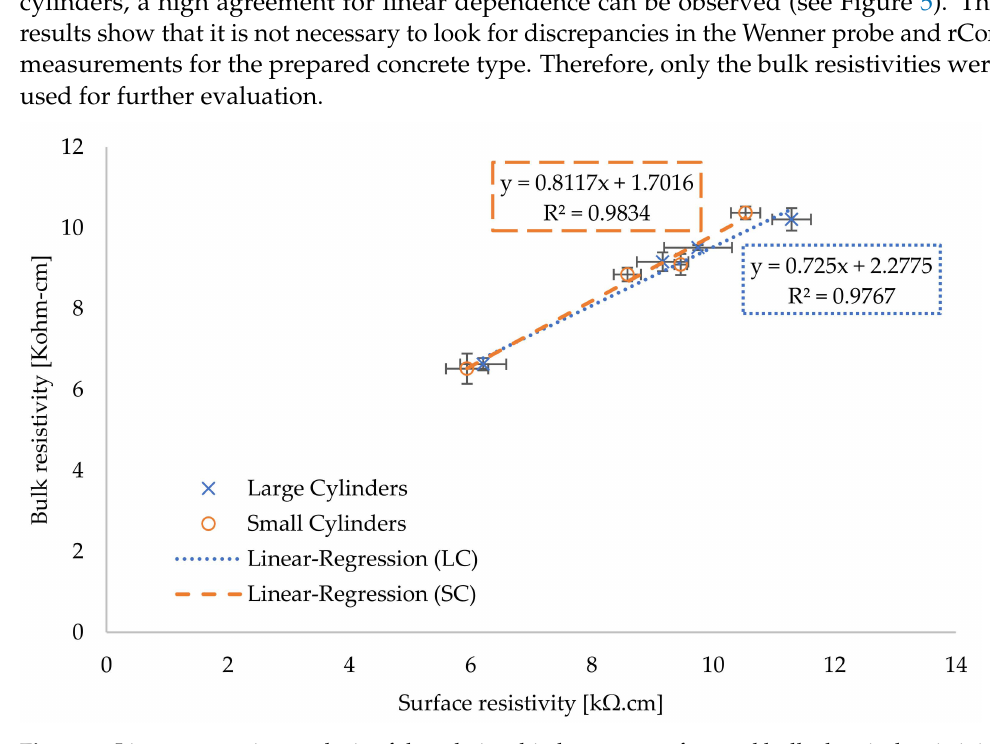
Figure 5. Linear regression analysis of the relationship between surface and bulk electrical resistivity on large and small cylindrical samples (LC = Large Cylinders, SC = Small